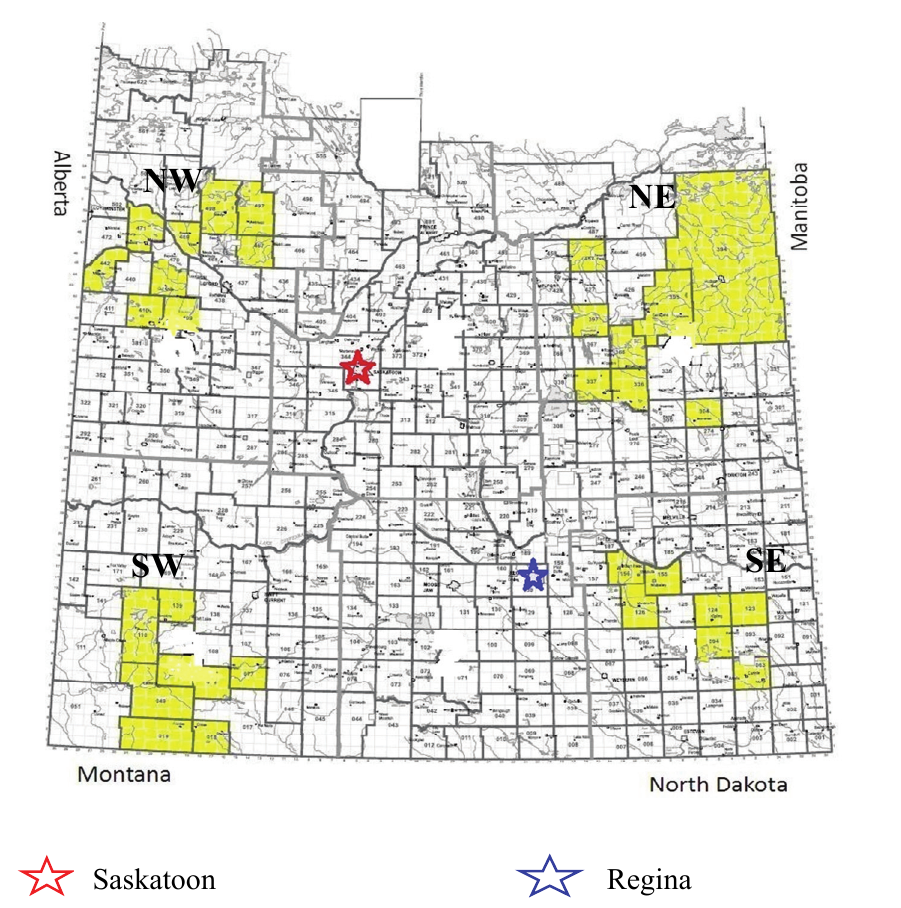
Figure 1. Map of study quadrants in the province of Saskatchewan,